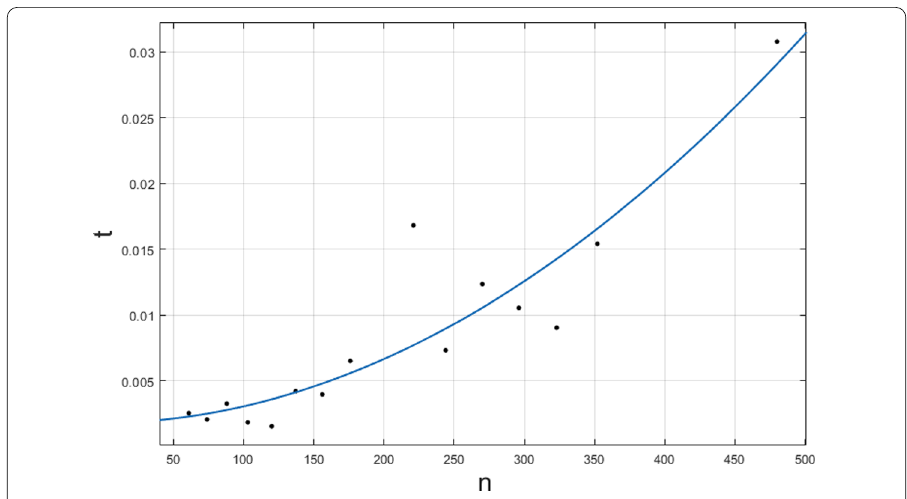
Figure 11 Quantity- time curve graph